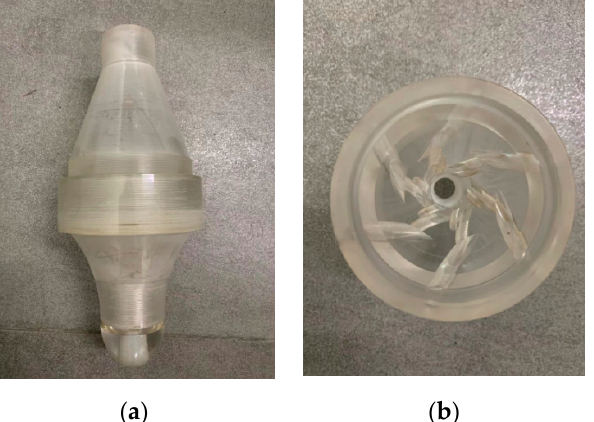
Figure 1. The schematic view of cyclone nozzle: ( a ) external shape of cyclone nozzle; ( b ) internal shape of cyclone nozzle.